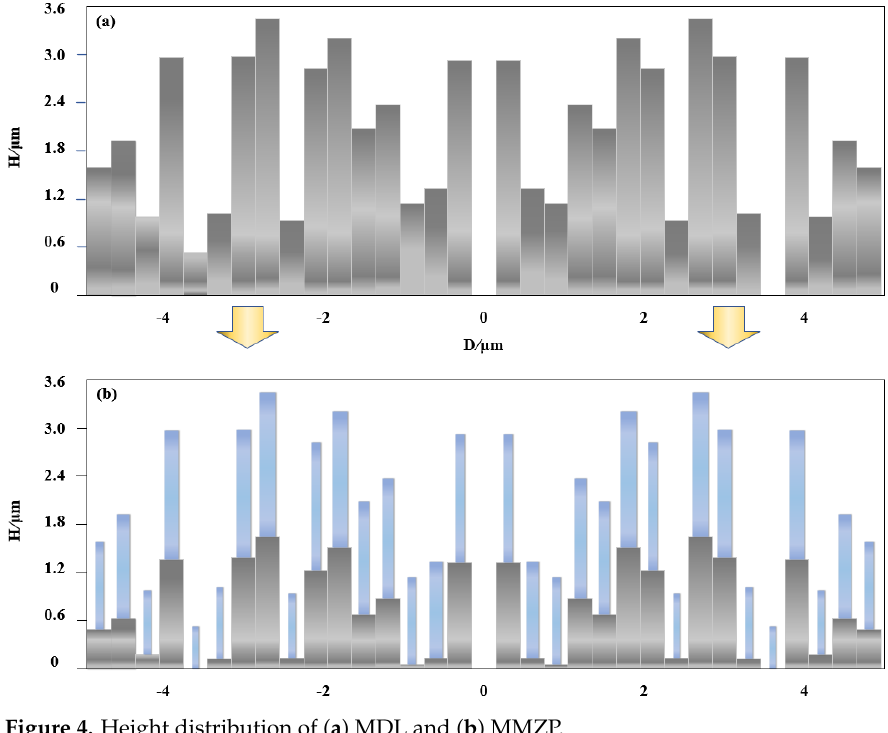
Figure 4. Height distribution of ( a ) MDL and ( b ) MMZP.